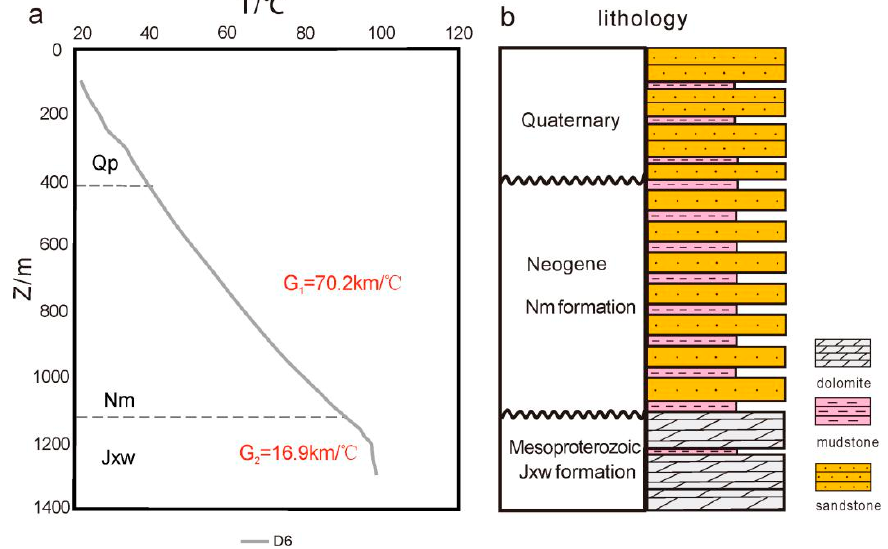
Figure 5. D6 well temperature profile ( a ) and the formation lithology column ( b ).